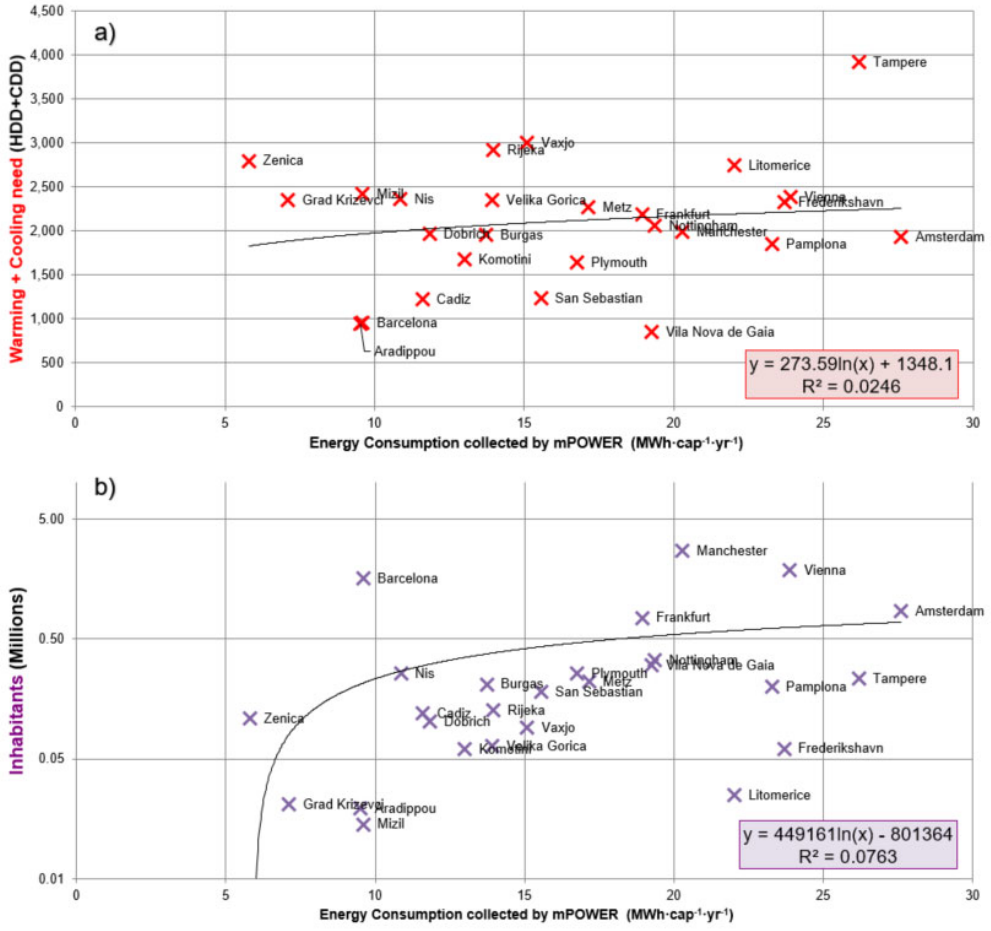
Figure 9. Energy consumption of each city, and the corresponding heating and cooling need according to the climate of each city (a), and the corresponding inhabitants (b). Table 1. Indicators used in the paper in order to analyse and compare the 27 cities.